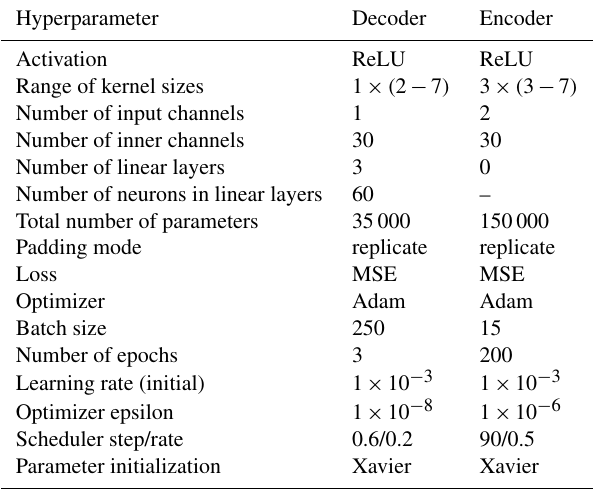
Table 3. Hyperparameters of the encoder and decoder neural net-